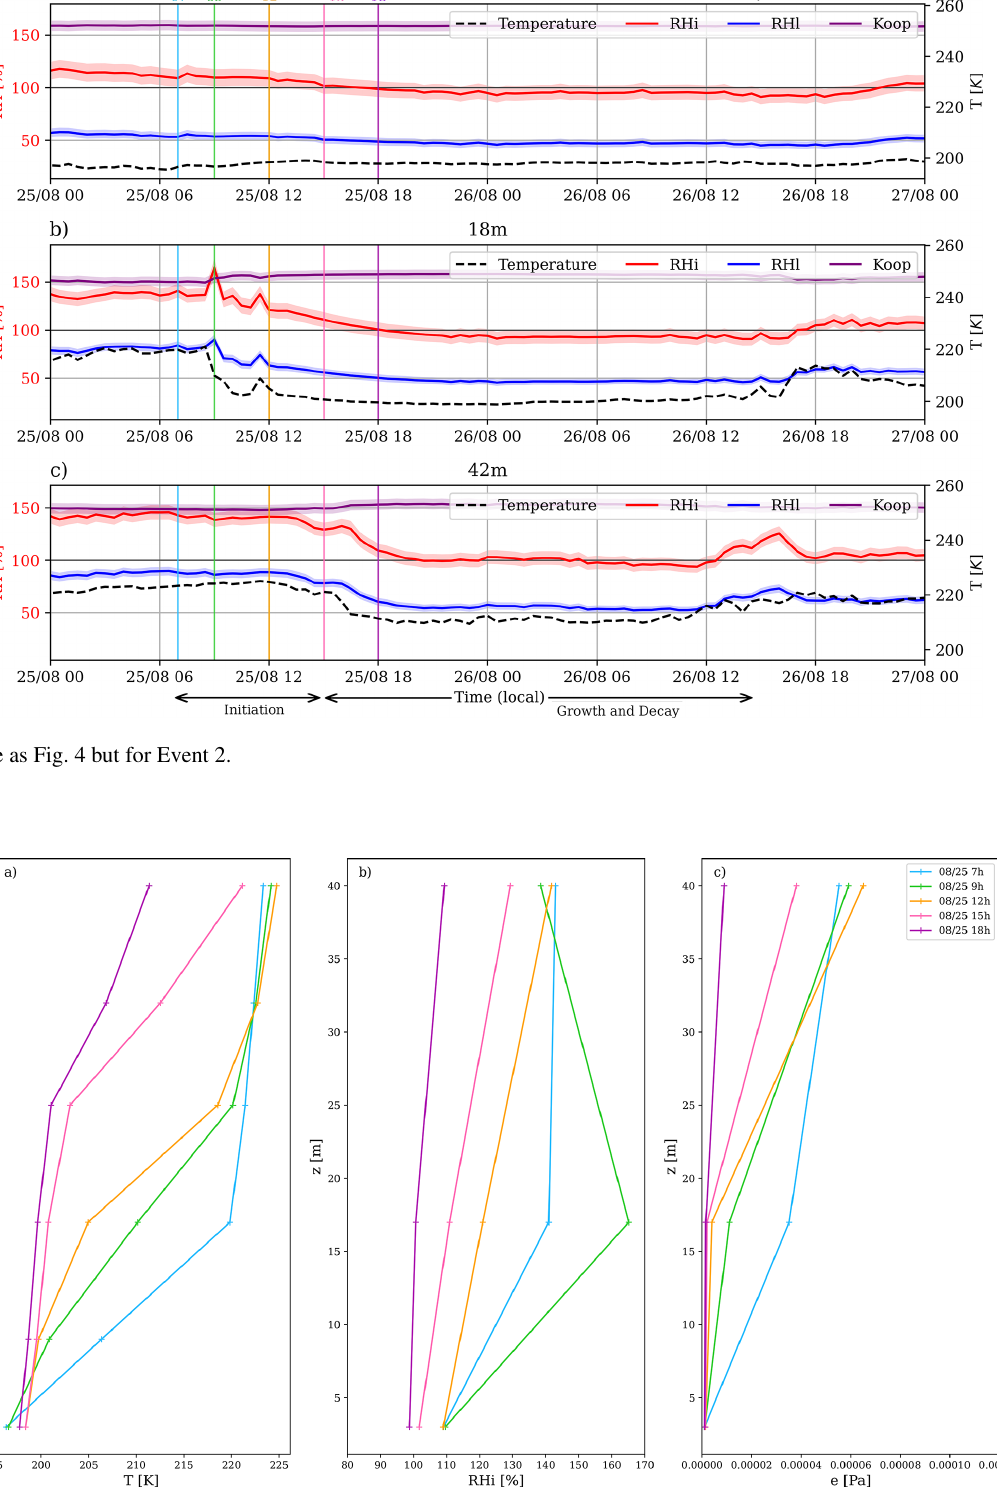
Figure 9. Same as Fig. 5 but for Event